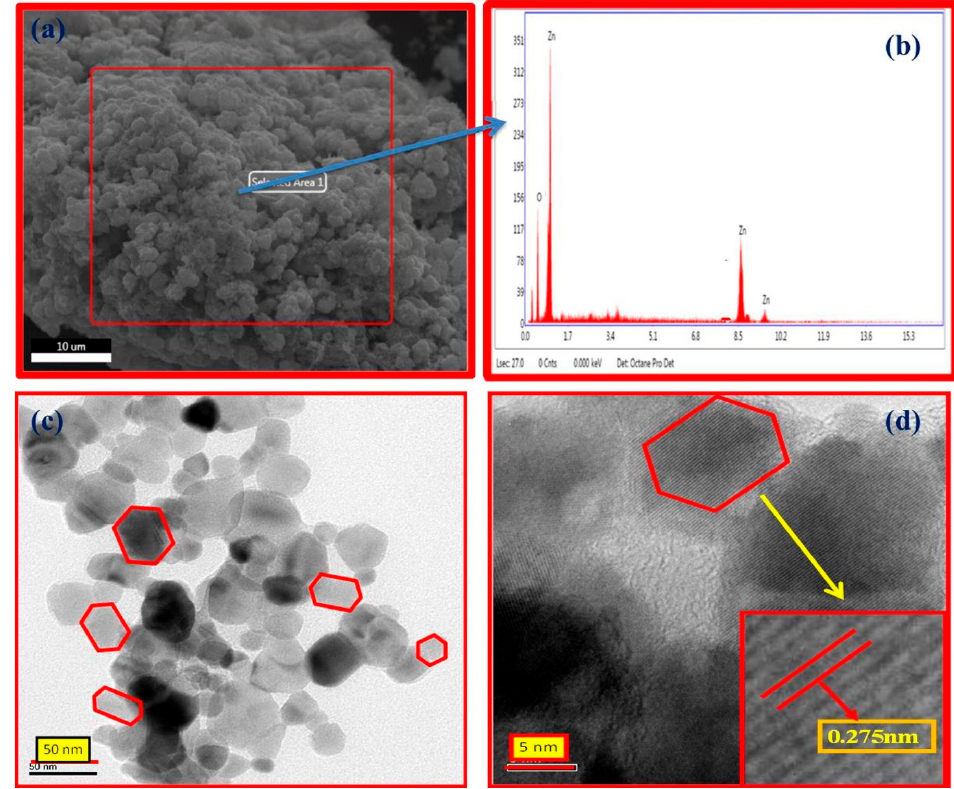
Figure 4. ( a ) SEM image ( b ) EDX ( c ) TEM, and ( d ) HR TEM images of M. arvensis -mediated ZnO NPs. Adapted from [110].